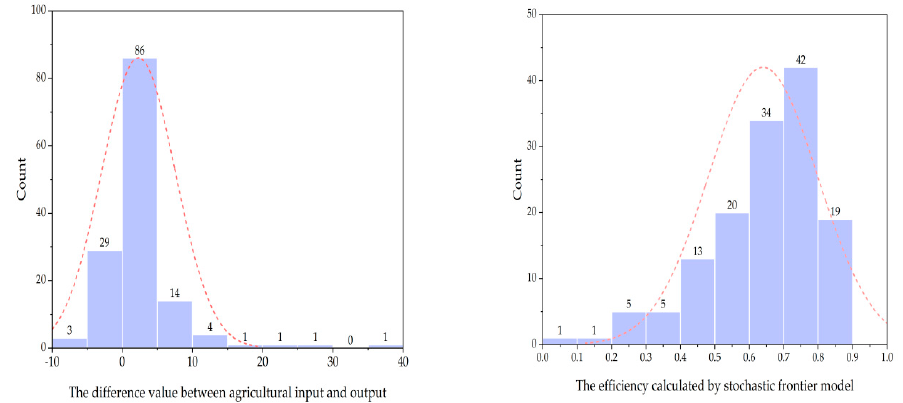
Figure 3. Distribution of agricultural production efficiency.